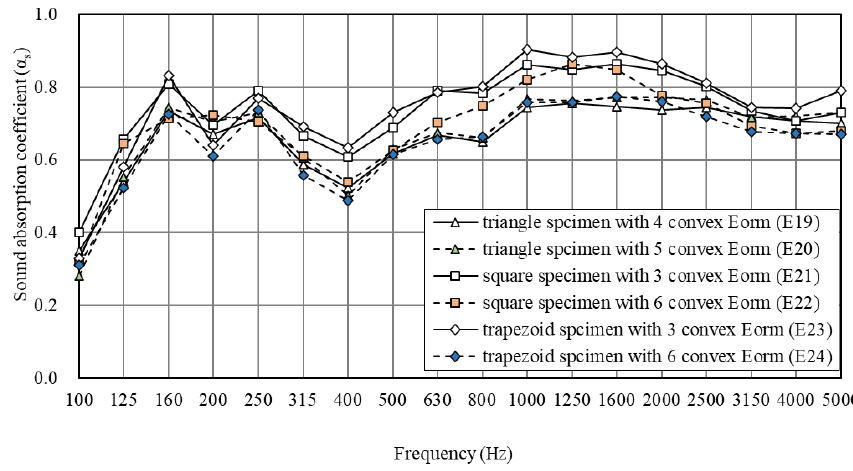
Figure 14. The sound-absorption coefficient of 55 mm FEMM with a 200 mm cavity. 4. Field Validation of FEMM 4.1. Field Environment This research selected an office room in a university as the study object for field ver- ification. The office is a rectangular room with a light steel joist structure on the ceiling and contained no other materials with sound-absorption properties except curtains, as shown in Figure 15. The volume of the space was 147.3 m 3 , the ceiling area was 46 m 2 , the installation area was 22 m 2 (61 pieces of the specimen), and the cavity behind the ceiling was 62.5 cm. Since the measuring environment had air conditioning, the noise criterion (NC) was 25, the temperature was 26.6 °C, and the relative humidity was 51.5%.